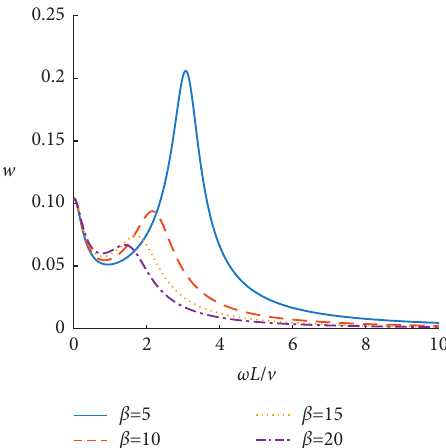
Figure 7: Influence of the parameter β on the deflection amplification factor at the midpoint of the